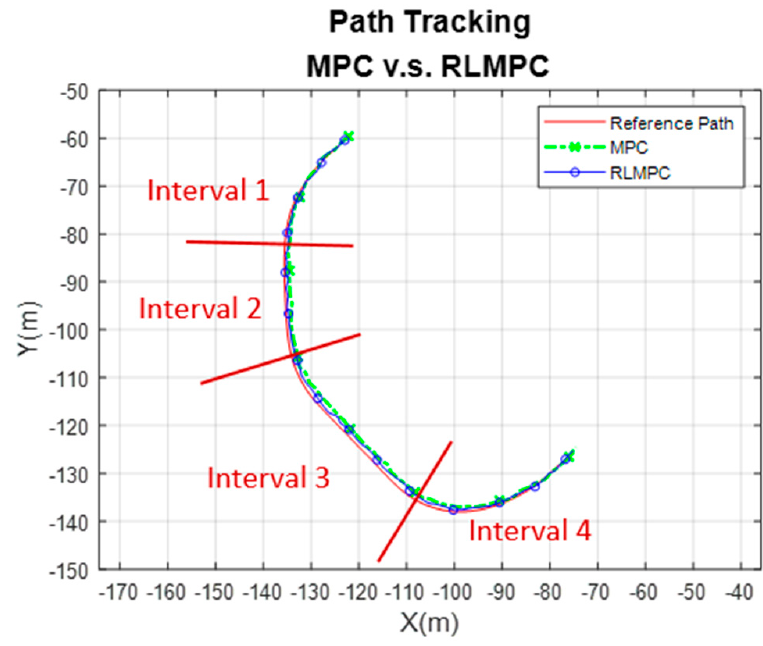
Figure 12. Trajectory comparison of MPC and RLMPC in scenario 2.